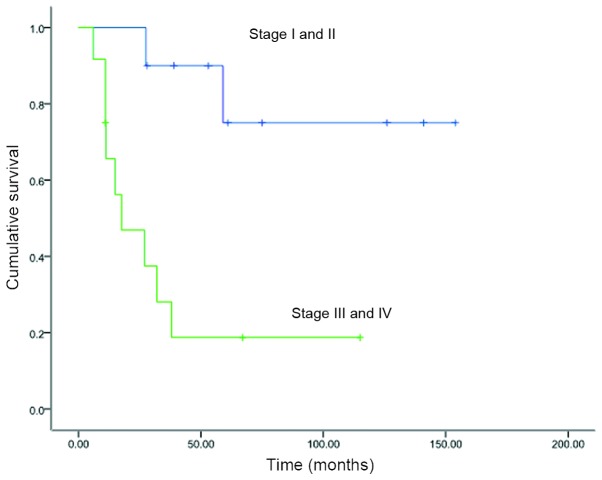
Kaplan-Meier curves comparing the survival time of patients with early (Stage I–II) and late (Stage III–IV) stage tumors (P=0.003).